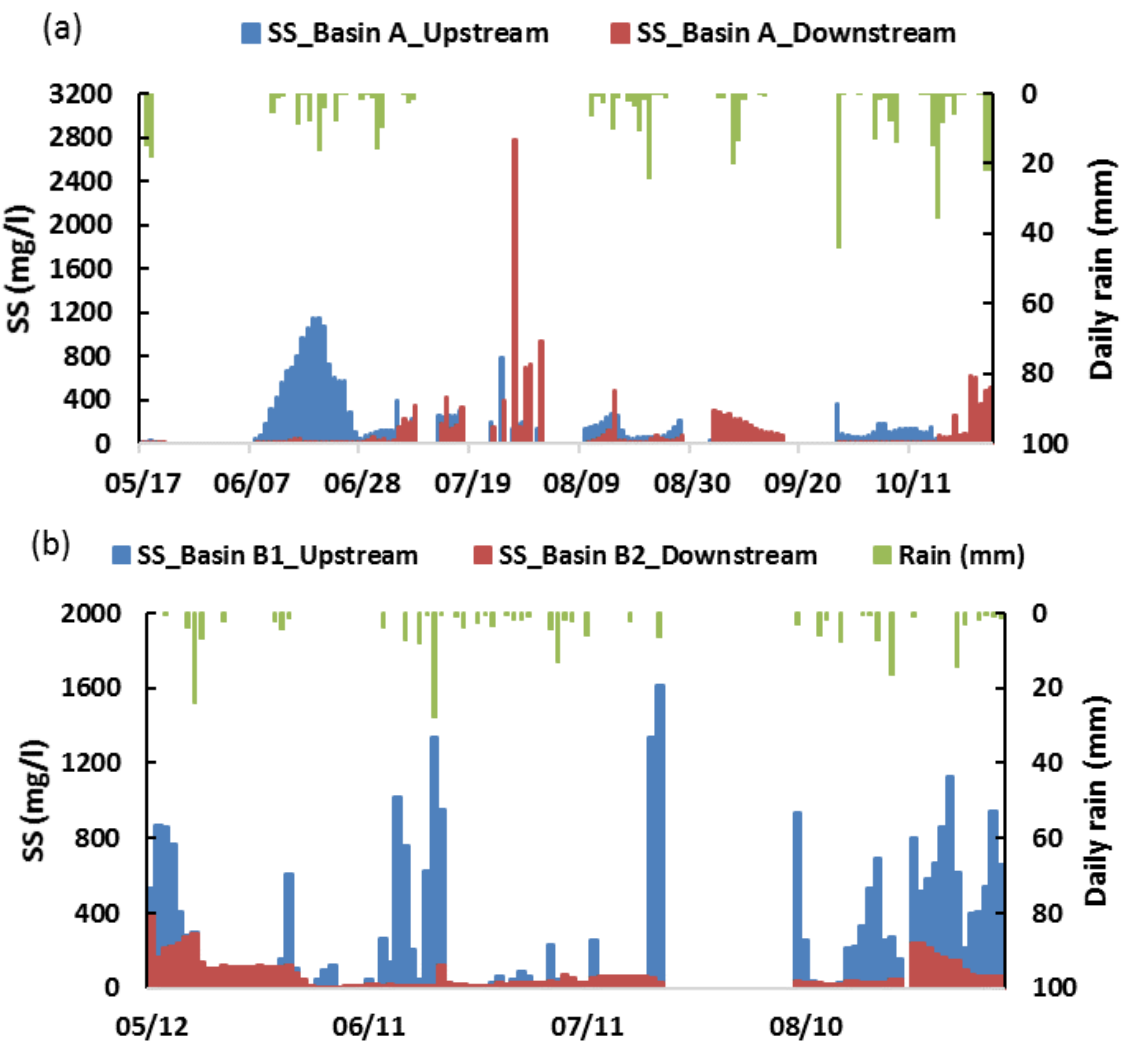
Figure 4. Time series of suspended sediment loads for (a) Basin A and (b) Basins